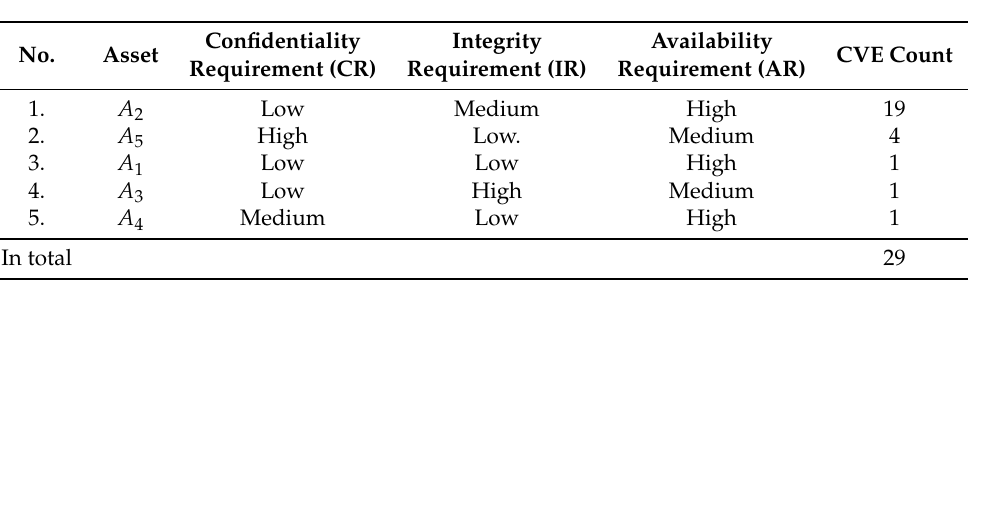
Table 8. The asset list with the “Medium-High” (MH) flag for the CDP and the number of CVEs detected for environment